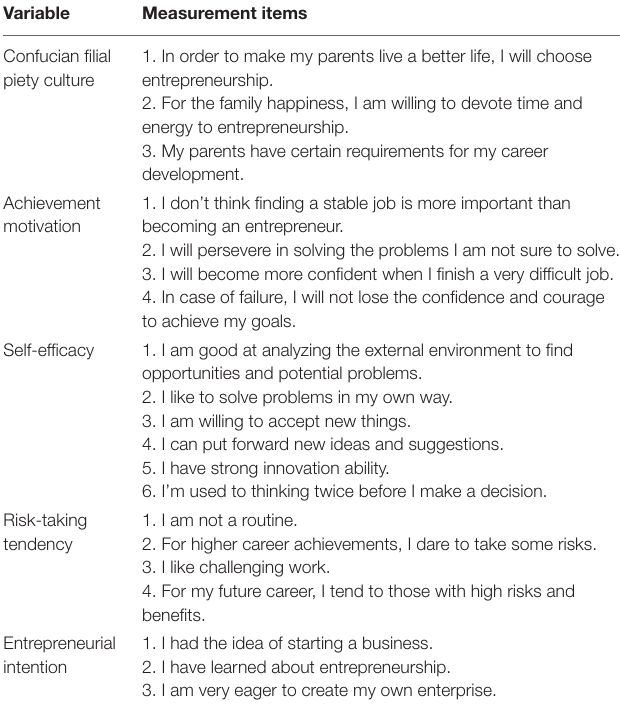
TABLE 3 | Validity test results of entrepreneurial